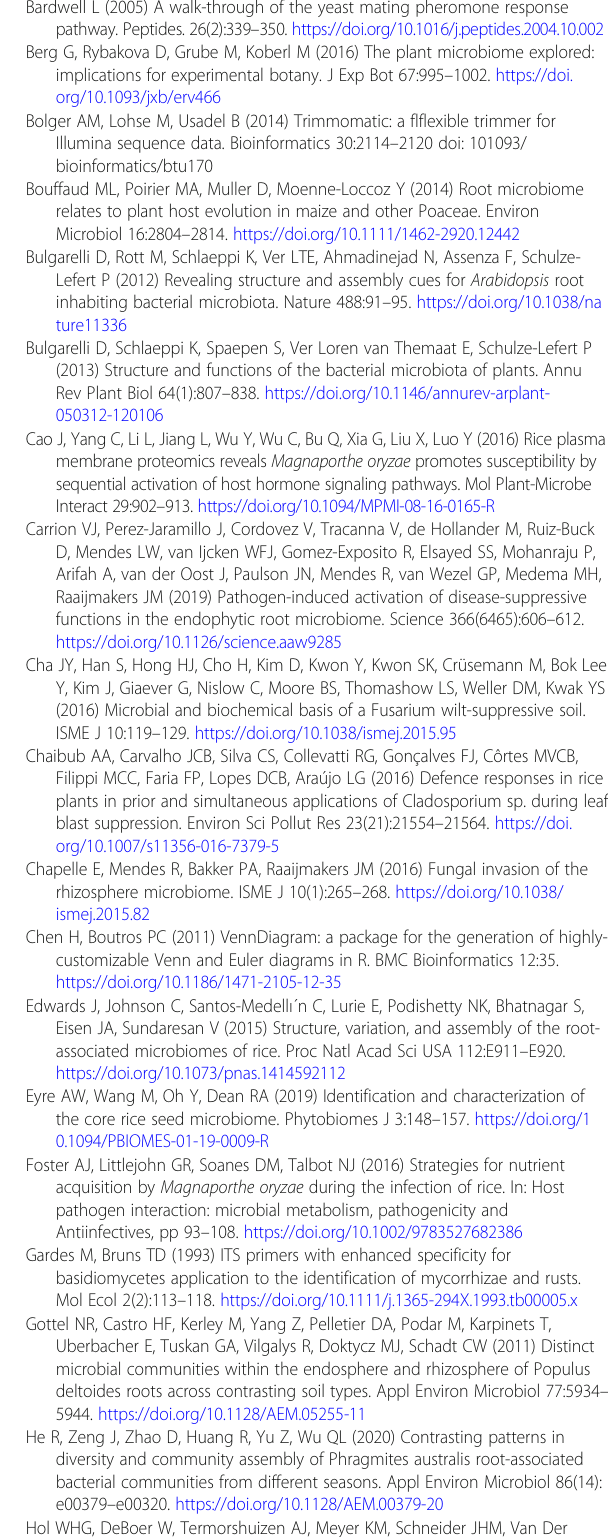
Additional file 5: Table S1. OTUs for bacterial and fungal communities. Additional file 6: Table S2. Topphylum for bacterial and fungal taxa across 8 compartments. Additional file 7: Table S3. Statistical table of alpha diversity index for bacterial and fungal communities. Additional file 8: Table S4. PCA for bacterial and fungal compartments.